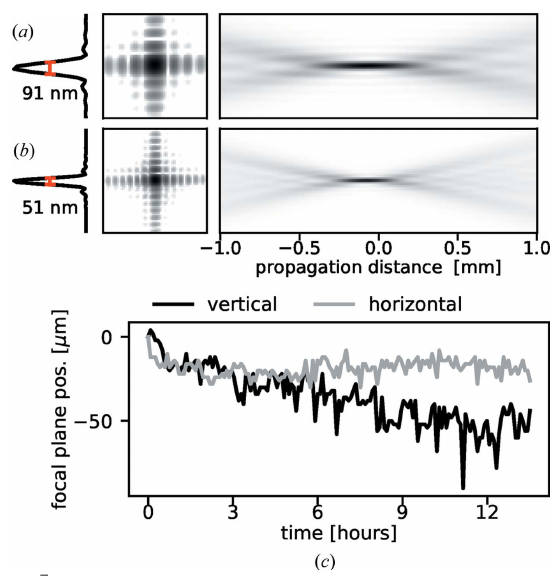
Figure 5 Beam profiles at ( a ) 10 keV and ( b ) 18 keV. The profiles in focus are determined by ptychographic imaging 300 m m out of focus and subsequent numerical wavefront propagation. The in-focus images (left) show intensity on a log scale, while the propagation images (right) show side views of the beam intensity on a linear scale. ( c ) The movement of the focal planes of the two mirrors along the beam propagation, measured with respect to their initial positions, during a 13.5 h experiment at 10 keV. At this energy, the depth of focus of the X-ray beam is 330 m m.